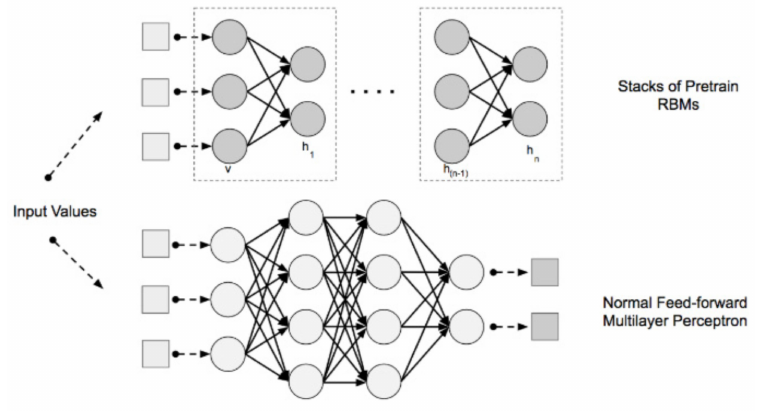
Figure 1. Deep belief networks (DBNs) architecture